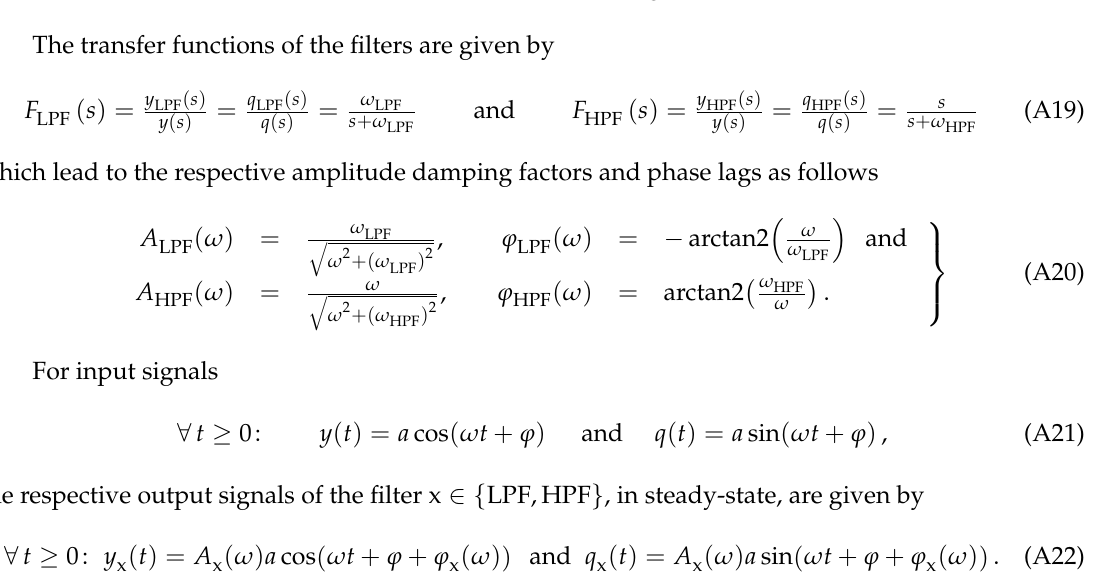
Figure A2. ( a ) Low-Pass Filter with APC and ( b ) High-Pass Filter with APC ( b